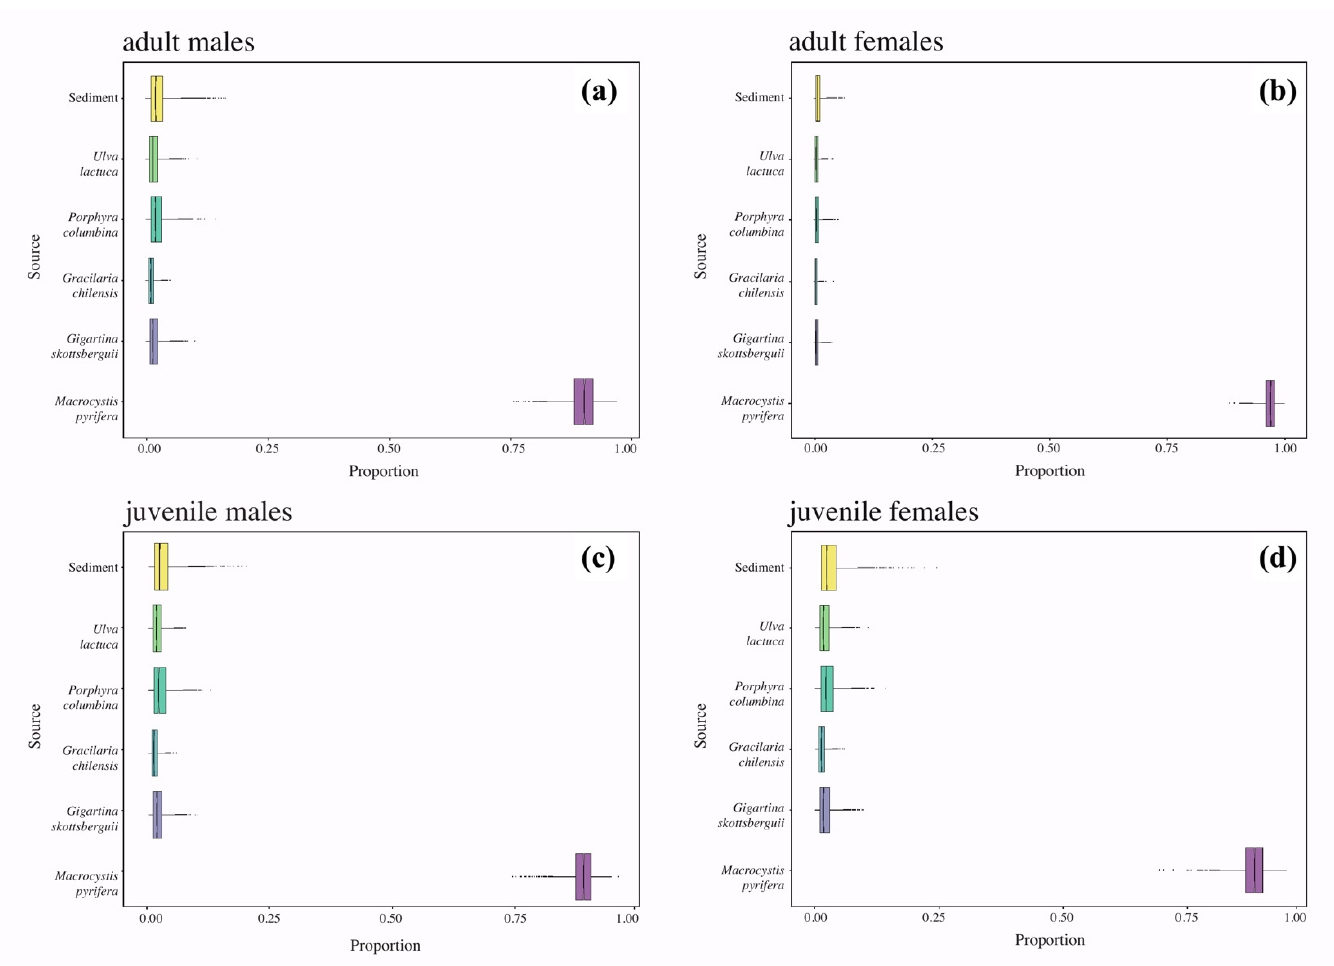
Figure 3. Results of SIMMR Bayesian mixing models showing proportional estimates of potential carbon sources (mean, 25% and 75% percentiles) to the diet composition of southern king crab Lithodes santolla by groups: ( a ) adult males, ( b ) adult females, ( c ) juvenile males, and ( d ) juvenile